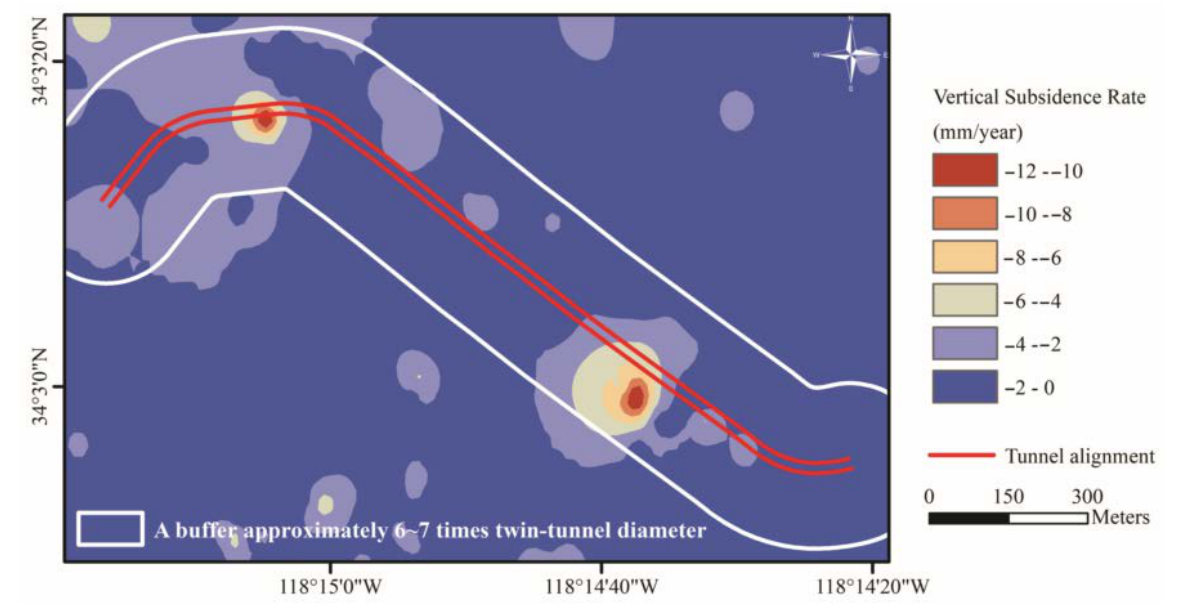
Figure 8. Average vertical settlement map along the twin-tunnel alignment.